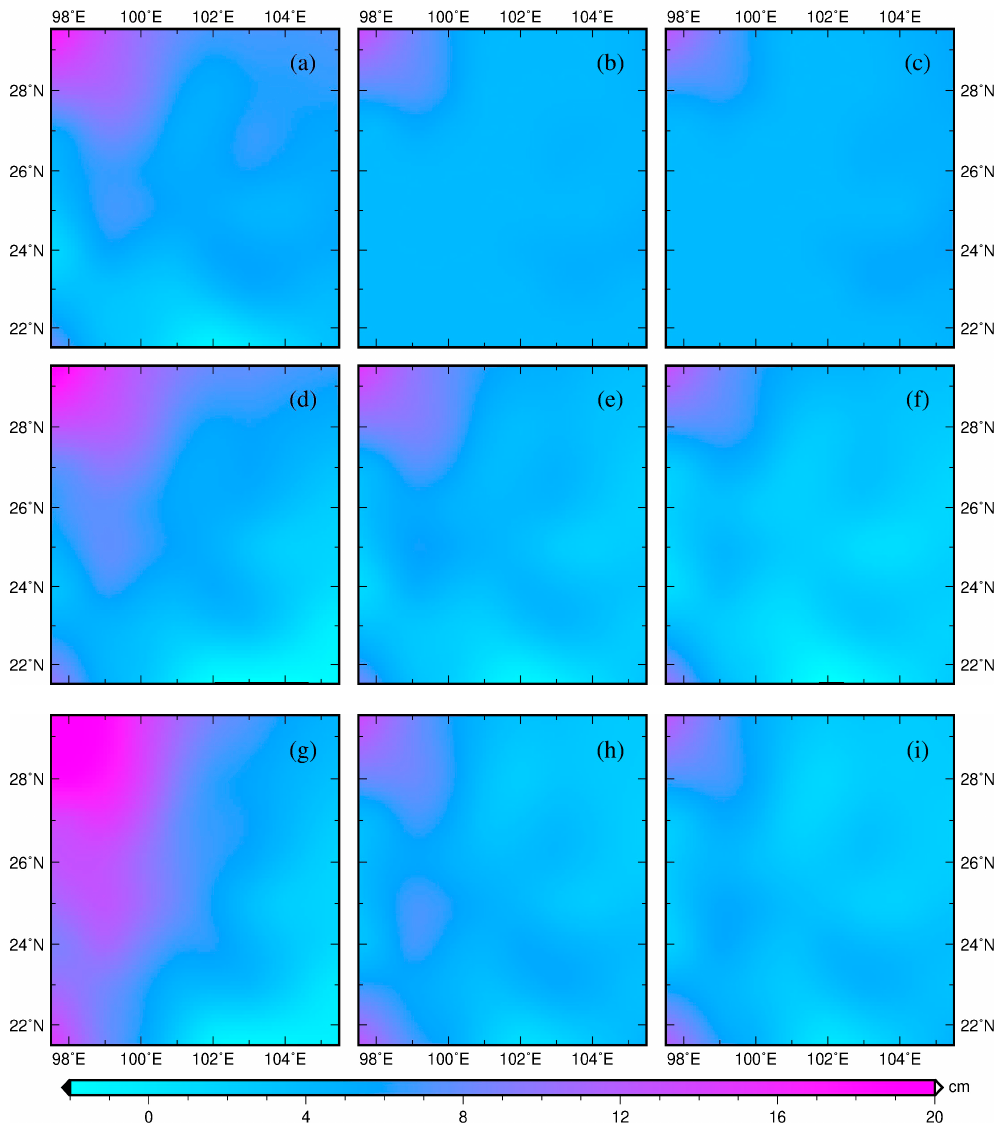
Figure 8. The bias of GPS-inferred TWS inverted by TR, ABIC, and HVCE, respectively, ( a , d , g ) without constraints, ( b , e , h ) with spatial GRACE data constraints and ( c , f , i ) with spatial GRACE data constraints and terrain-corrected GPS, respectively, against GLDAS-modeled TWS.